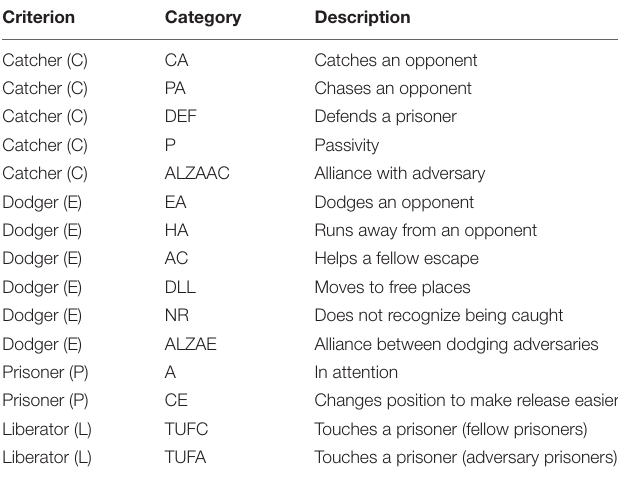
TABLE 1 | Registration system (4 criteria and 15 categories nested within the